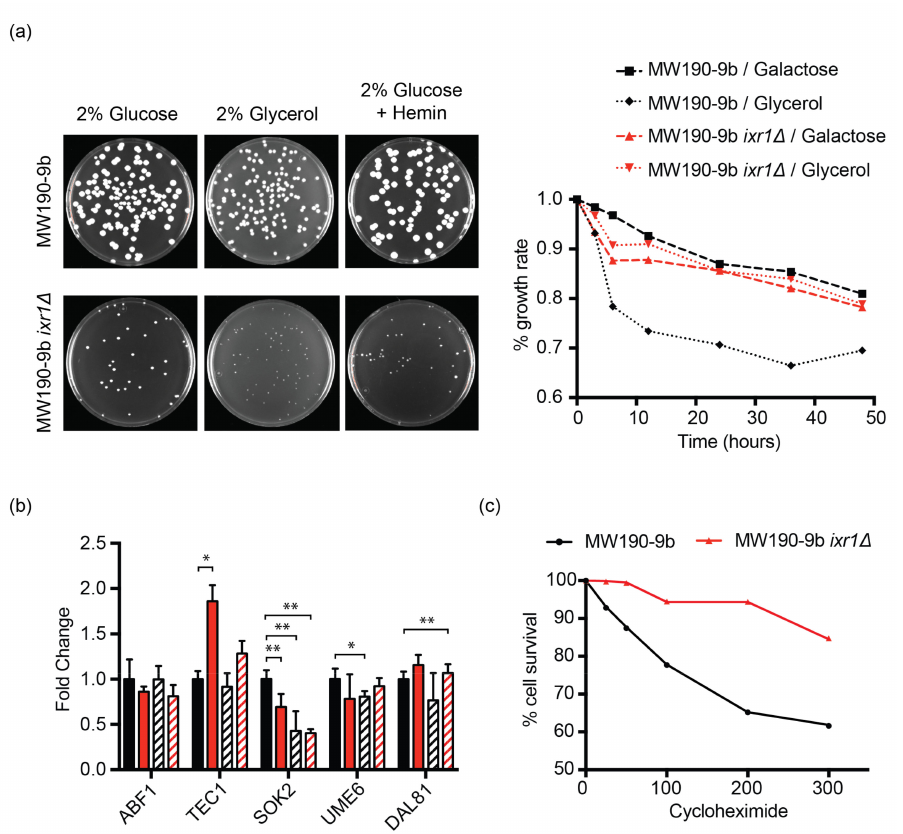
Figure 7. Analysis of petite phenotype in MW190-9b ixr1 ∆ null mutant. ( a ) (left) Colony size of MW190-9b strain and its derivative ixr1 ∆ in 2% w/v glucose, 2% w/v glycerol, or 2% w/v glucose supplemented with 50 µ g/mL hemin. (right) Growth tracking of MW190-9b strain (black) and its derivative ixr1 ∆ (red) 2% w/v galactose or 2% w/v glycerol during 48h. Growth rates were calculated using respective 2% w/v glucose cultures as normalization elements. ( b ) RT-qPCR results of KlABF1 , KlTEC1 , KlSOK2 , KlUME6, and KlDAL81 genes in wild-type (black) and ixr1 ∆ null strain (red), before (solid) and after (streaked) the treatment with 600 µ M of the chemotherapeutic agent cisplatin. Housekeeping gene KlTAF10 was used for gene normalization. * p < 0.05; ** p <0.01. ( c ) Cellular response to cycloheximide treatment. Cell cultures of the K. lactis strain MW190-9B (black) and its isogenic derivative MW190-9B- ixr1 ∆ (red) were treated with several concentrations of cycloheximide (0, 25, 50, 100, 200, and 300 µ g/mL). After 24 h of growth at 30 ◦ C, optical density measurements at 600 nm were taken, and survival rates were calculated by normalization from untreated